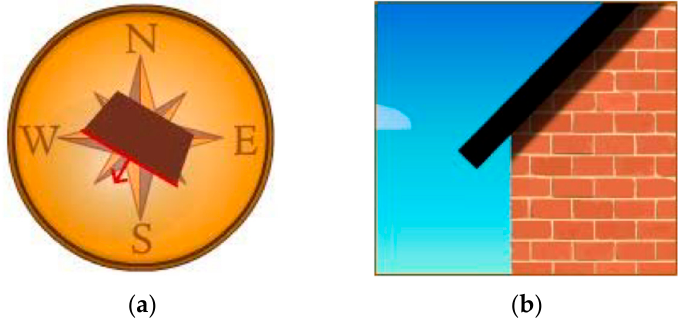
Figure 3. Spatial dimensions: ( a ) azimuth and ( b ) tilt.